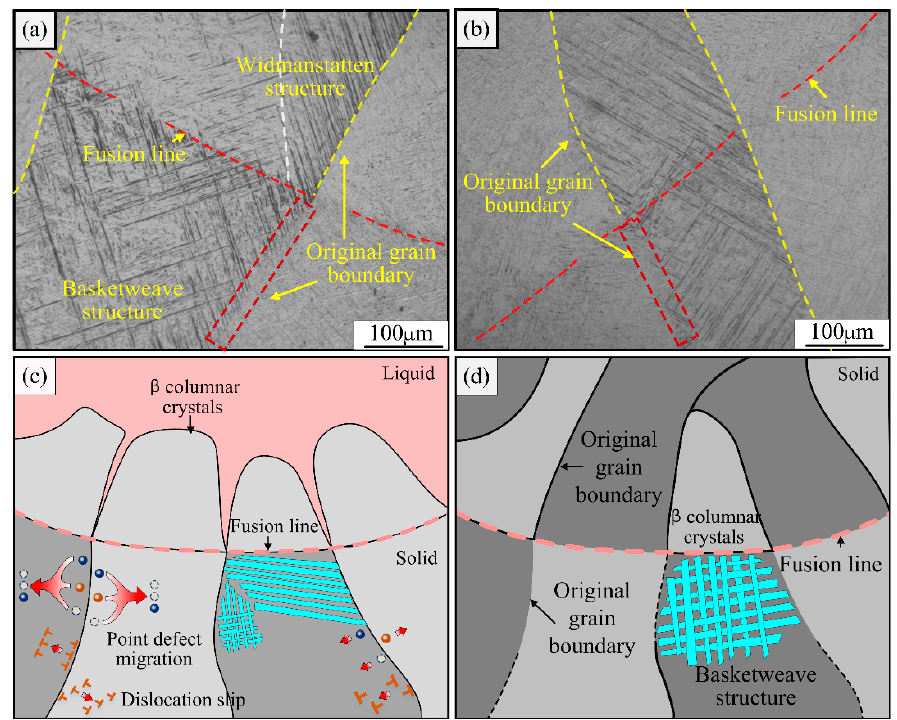
Figure 10. Analysis of the mechanism of the influence of the welding thermal cycle characteristics on the heat-affected zone below the fusion line: ( a ) cover layer, ( b ) intermediate layer, ( c ) microstructure evolution of the original β grain boundary during welding, ( d ) microstructure of the original β grain boundary after welding.